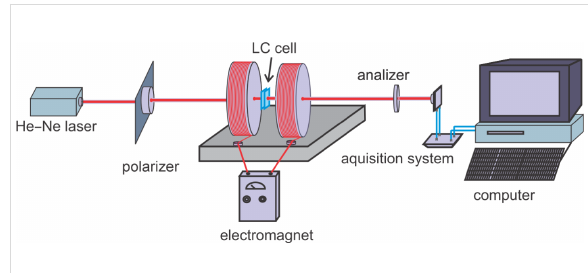
Figure 3: Experimental setup for the study of the internal organization of the mixture of 5CB with CoFe 2 O 4